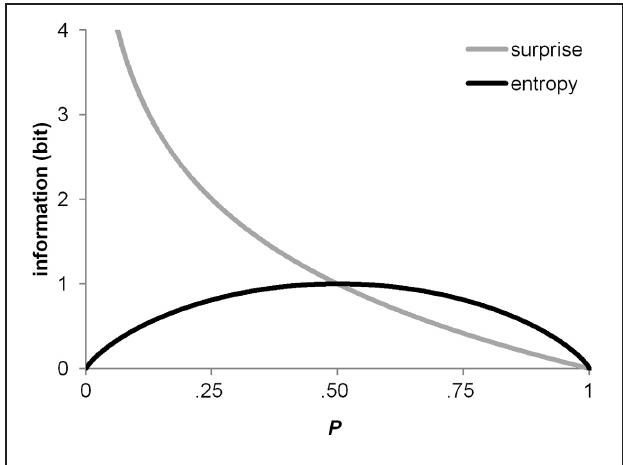
FIGURE 3 | The surprise function and the entropy function as a function of probability over a binary random